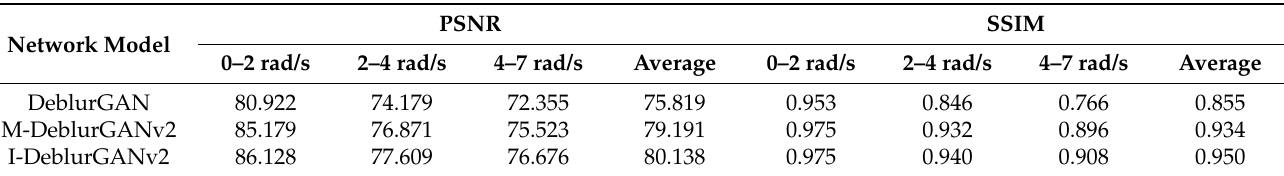
Table 1. PSNR and SSIM of G ( I b ) with different rotational velocities.